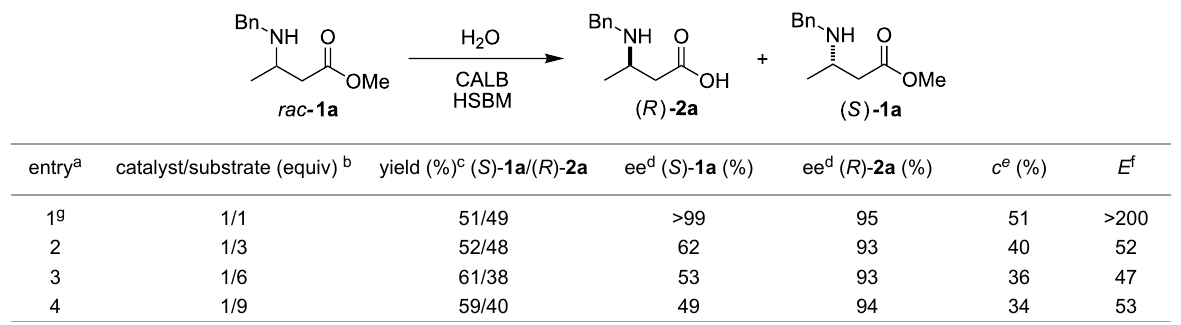
a Reactions were carried out with 0.5 equivalents of water at 15 Hz during 1 h. b 1 equivalent of enzyme = 40 mg; 1 equivalent of susbtrate = 82 mg. c Determined after purification by flash chromatography. d Determined by HPLC with chiral stationary phase. e Calculated from c = ee s /(ee s + ee p